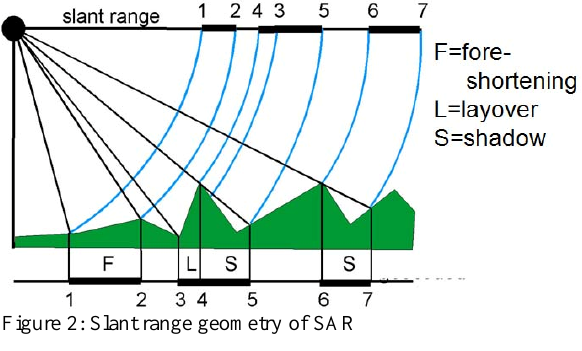
Figure 2: Slant range geometry of SAR